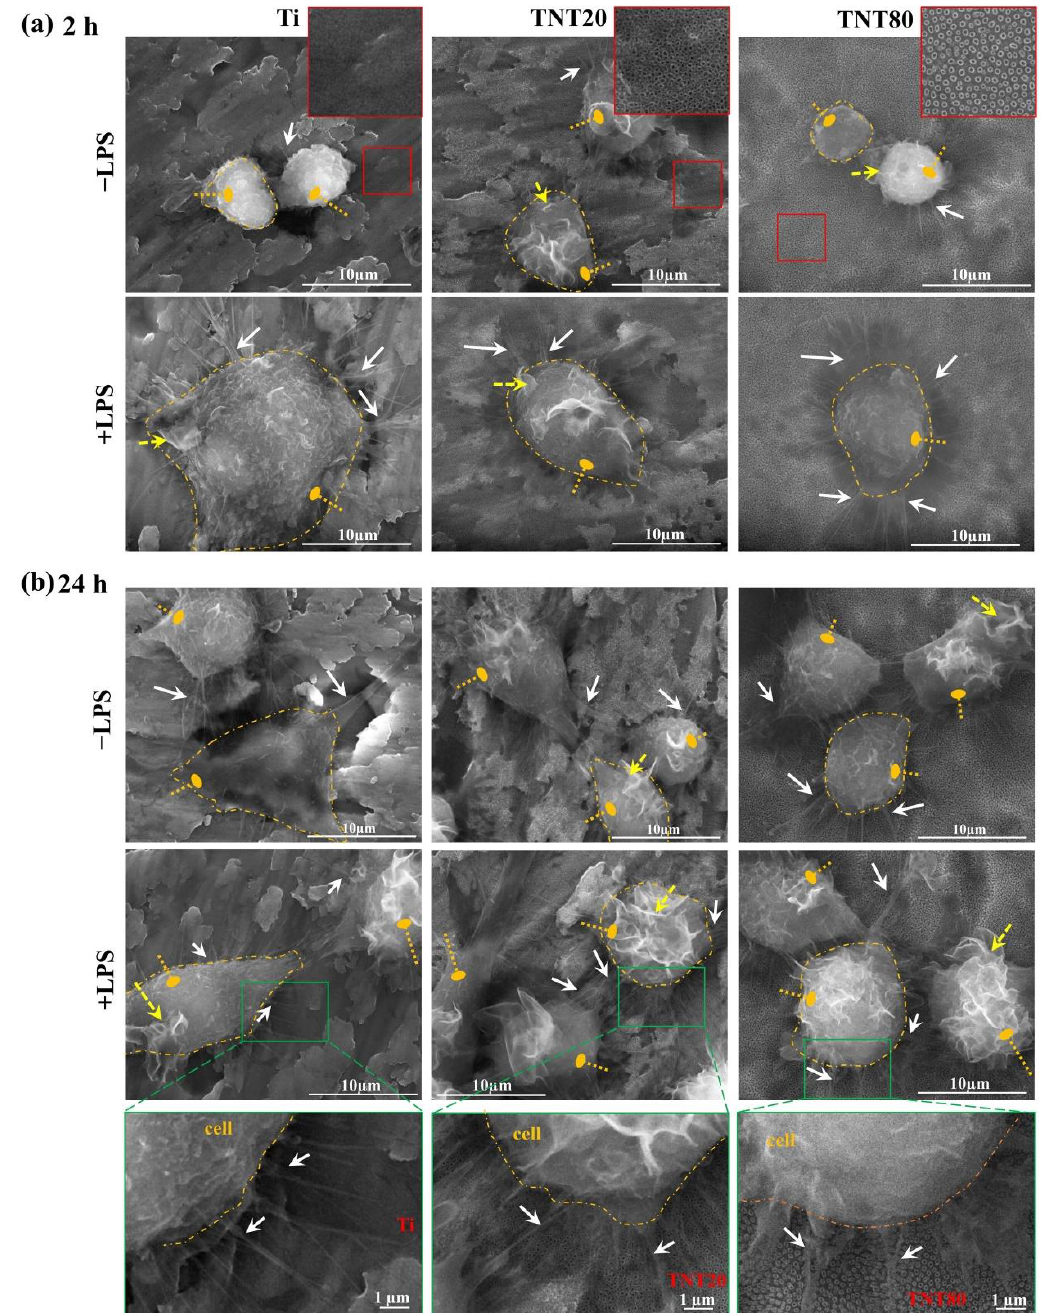
Figure 2. SEM micrographs of the RAW 263.7 macrophages maintained in contact with Ti, TNT20, and TNT80 surfaces for ( a ) 2 h and ( b ) 24 h, under standard (−LPS) and pro-inflammatory (+LPS) culture conditions (for each condition, a cell is delineated with dashed orange lines; oval arrow—cells ; white arrow—filopodia ; dashed yellow arrow—membrane ruffling ). Insets in ( a ), marked red squares, show the morphology of the corresponding substrate. In the higher magnification images of the area marked with green squares for 24 h, +LPS condition ( b ), the cell membrane is delineated (orange dashed line) and the filopodia (white arrows) are indicated.